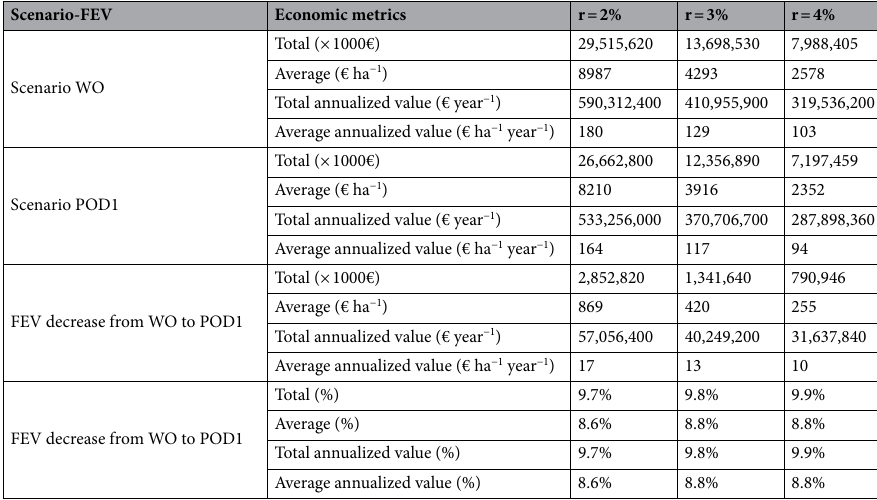
Table 1. Forest expectation value (FEV) under no ozone damage scenario (WO) and with a forest-type specific reduction in the annual forest increment as estimated on the basis of the phytotoxic ozone dose (POD1). Results are for the Italian forests in 2005, with different interest rates r.